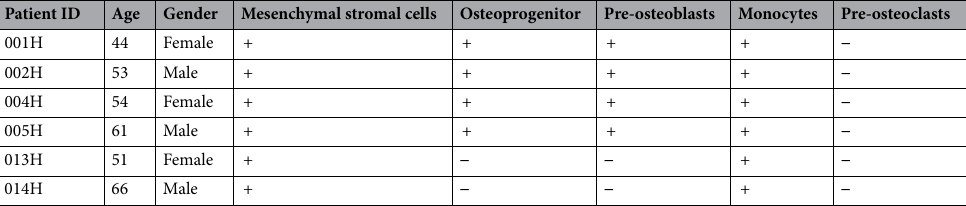
Table 1. Overview of patients included in this study and their evaluated capacity to respond ( +) or not respond (−) to supraphysiological loading with the release of osteoclast-stimulating soluble